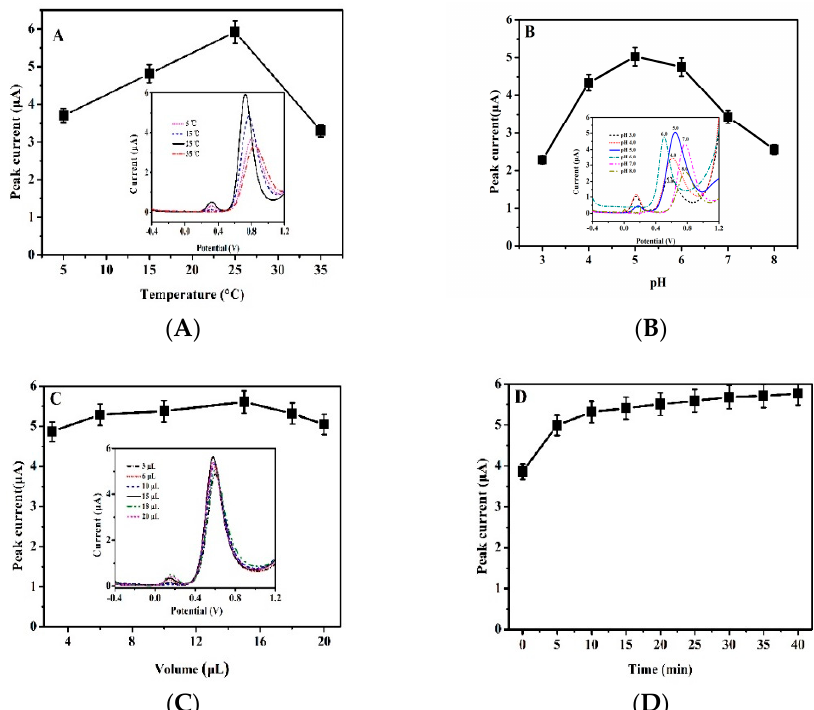
Figure 5. Current responses (The inserts are DPV curves) for 50 μ mol·L − 1 nitrite oxidation on Fc-ECG/SPE sensor in 0.1 mol·L − 1 PBS with a pulse amplitude of 50 mV. ( A ): pH 7.0, at 5, 15, 25 and 35 °C; ( B ): pH 3.0, 4.0, 5.0, 6.0, 7.0, 8.0, at 25 °C; ( C ): pH 5.0, with 3, 6, 10, 15, 18, 20 μ L of Fc-ECG on electrode at 25 °C; ( D ): pH 5.0, with 0-40 min reaction time at 25 °C.